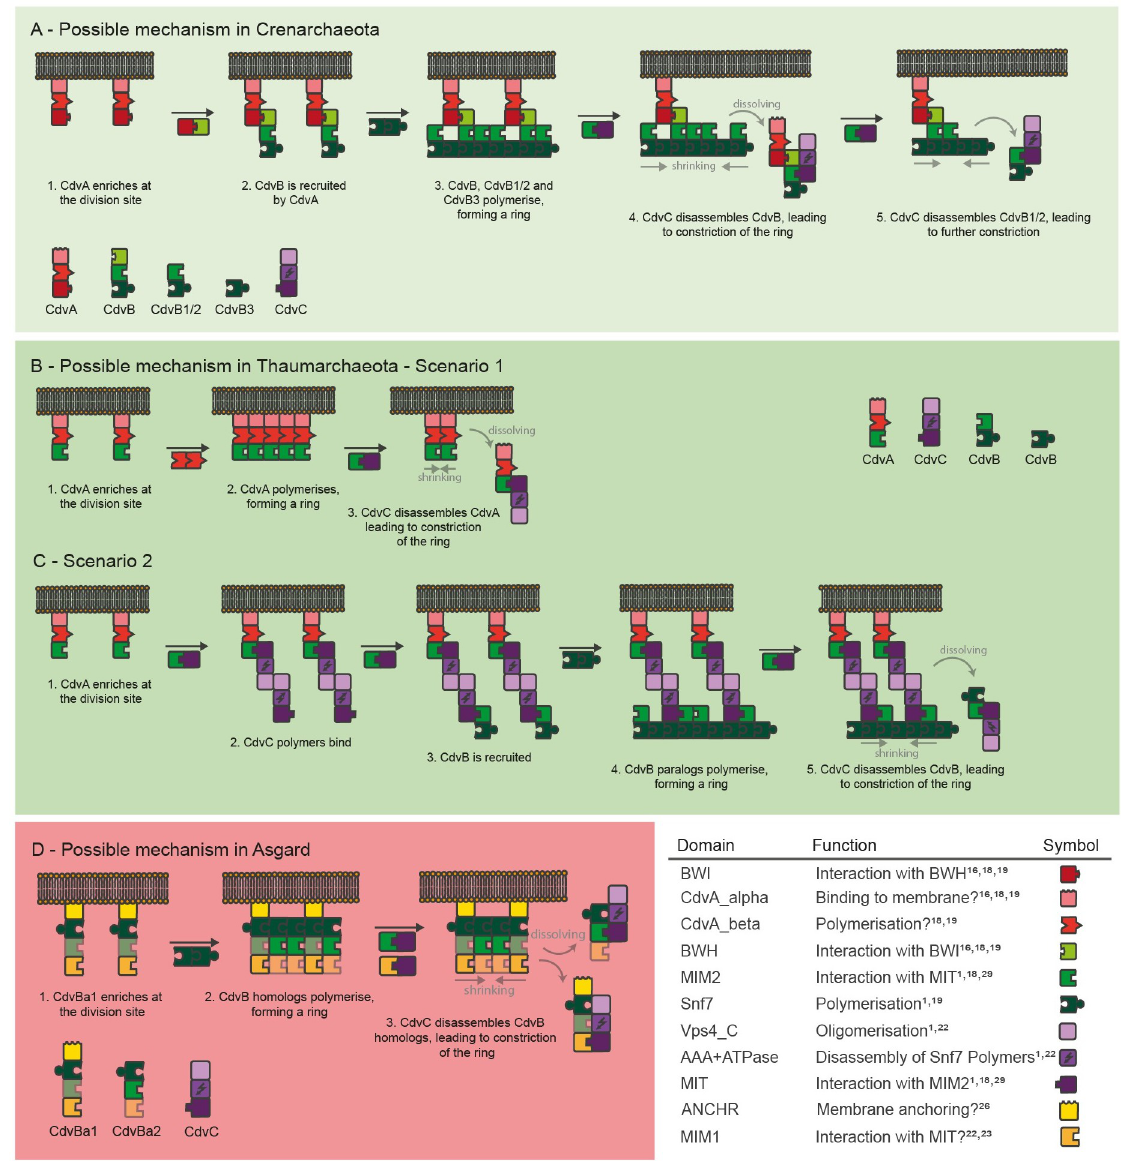
Fig 4. Possible mechanisms of Cdv-based cell division in Crenarchaeota, Thaumarchaeota and Asgard. Proteins are displayed as sets of building blocks as in Fig 2. Importantly, these mechanisms are not results of mathematical modelling, but are a qualitative explanation based on PPI networks ( S1 Fig ). A : The possible mechanism in Crenarchaeota is characterised by a sequential enrichment of CdvA, CdvB, CdvB1/ 2 and -3, followed by depolymerisation by CdvC. B : In the first scenario in Thaumarchaeota, CdvB homologs are not involved at all and ring-formation is instead relying on polymerisation of CdvA. C : The second scenario in Thaumarchaeota involves CdvB polymerisation, which is connected to CdvA by CdvC acting as linker. We strongly doubt this scenario. D : In Asgard archaea, the possible mechanism starts by CdvBa1 homologs binding to the membrane, differing from TACK archaea. CdvB homologs may then polymerise, form a ring, and get depolymerised by